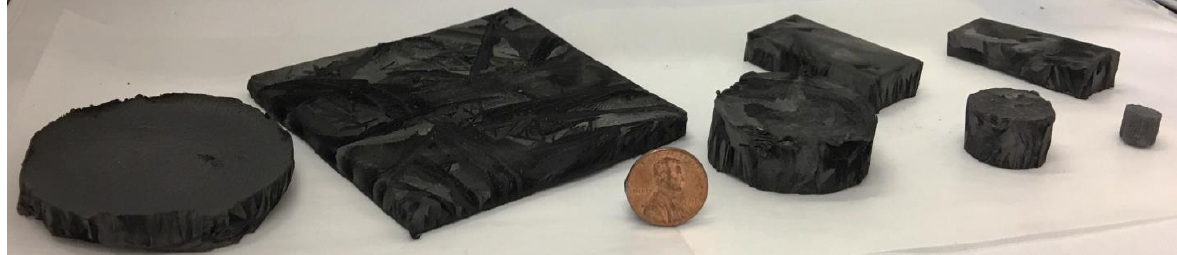
Figure 10. 3D GNP foam produced in various sizes, shapes, and thicknesses by FD technique to highlight the scalability of the process with ease .